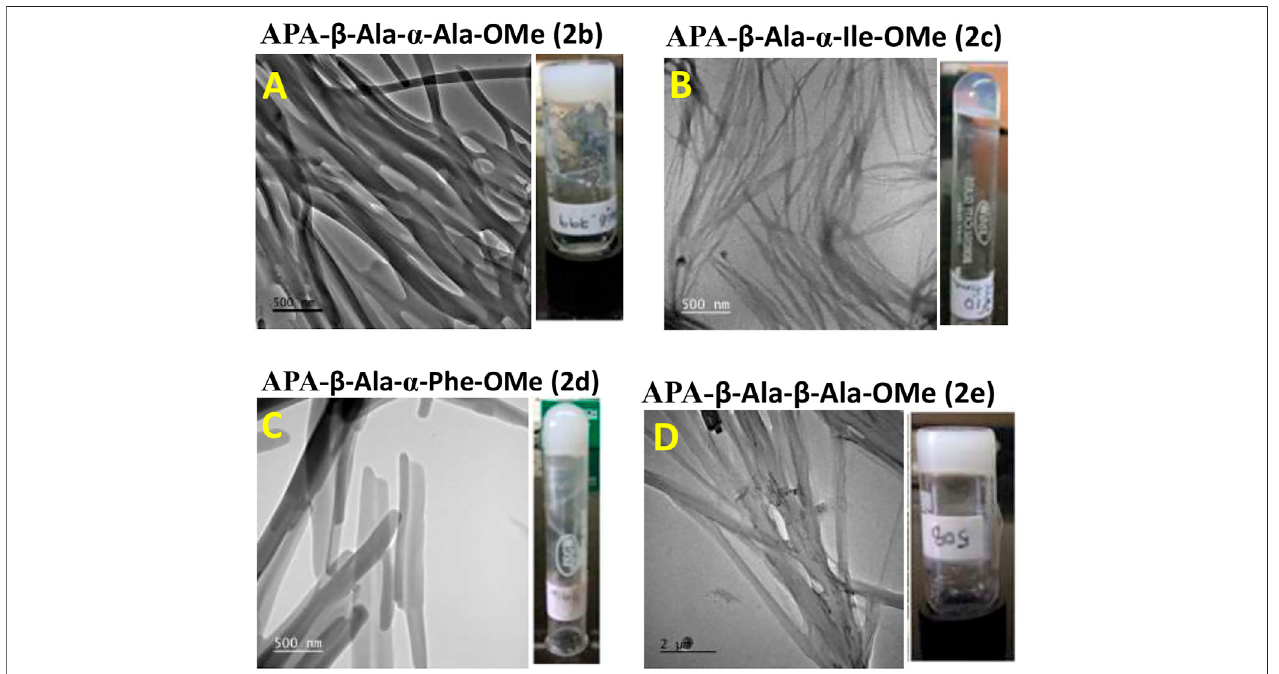
FIGURE 2 | TEM image of APA-peptide organogels. Peptide APA- β -Ala- α -Ala-OMe, 2b (A) ; peptide APA- β -Ala- α -Ile-OMe, 2c (B) ; peptide APA- β -Ala- α -Phe- OMe, 2d (C) ; and peptide APA- β -Ala- β -Ala-OMe, 2e (D) .